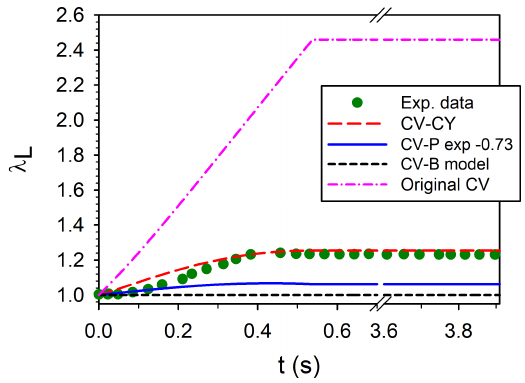
Figure 4: Normalized droplet length during and after a step shear experiment (from [22]) compared to the original CV, CV-CY, CV-B and CV-P models. In the experiment, the shear thinning droplet was subjected to step shear at 8 s −1 for 0.54 s, and then flow is stopped. The prediction curves show that the droplet does not retract after the shearing flow was